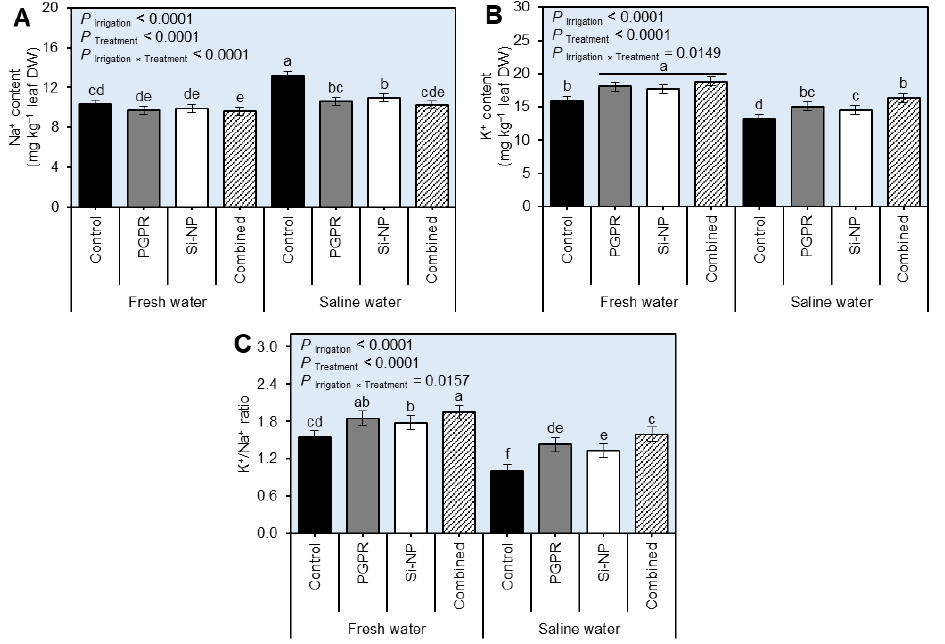
Figure 4. Effect of seed inoculation with PGPR and/or Si-NP foliar application on the water re- lations and chlorophyll reading of sugar beet plants grown in salt-affected soil and subjected to saline water irrigation during the 2019/2020 seasons. ( A ) Na + content (mg kg − 1 leaf DW), ( B ) K + content (mg kg − 1 leaf DW), and ( C ) K + /Na + ratio during the 2019/2020 seasons, respectively. Data presented are the means ± standard deviation (mean ± SD) of three biological replicates. Differ- ent letters signify statistically significant differences between treatments according to Tukey’s HSD test ( P Irrigation × Treatment ≤ 0.05).